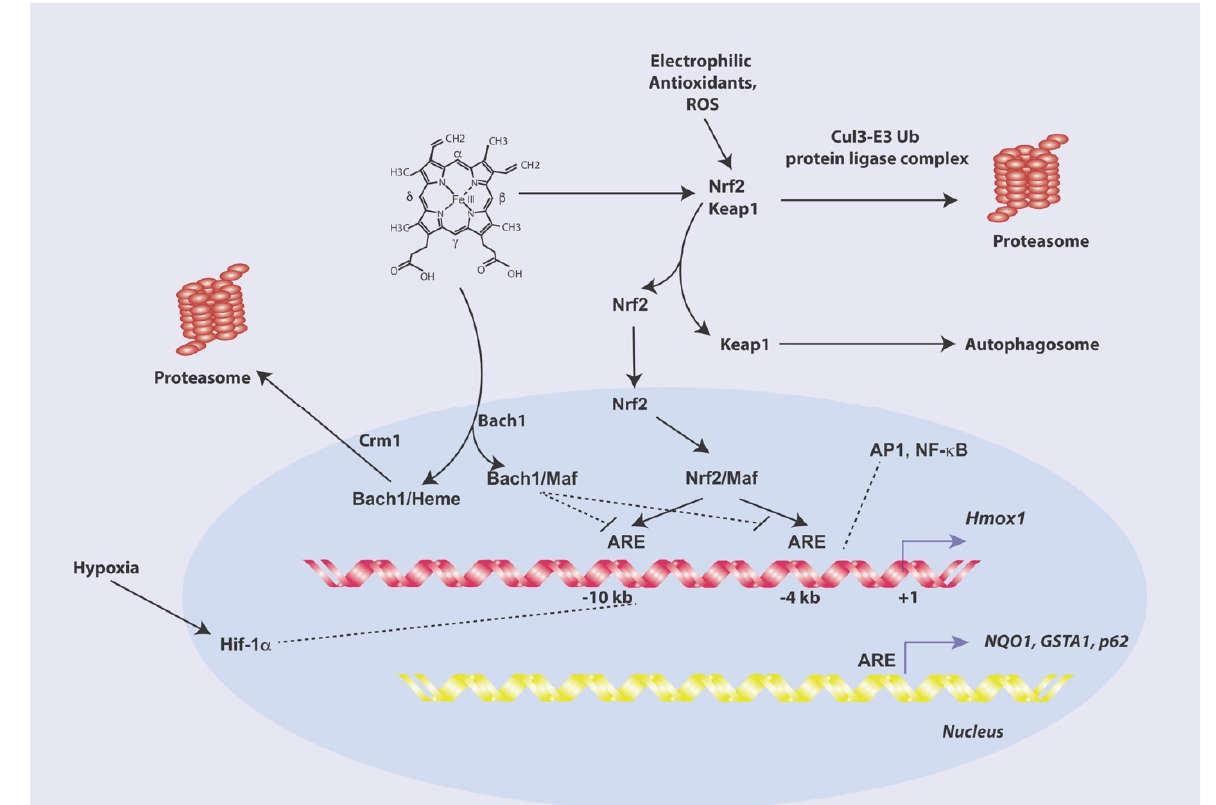
Figure 2. Regulation of HO-1 gene expression. The Hmox1 gene contains distal enhancer regions located at − 4 kb and − 10 kb and additional cis -elements in the proximal promoter region. HO-1 responds to transcriptional regulation by heme, electrophilic compounds, ROS, heavy metals and other diverse stimuli. HO-1 gene expression in response to diverse agents is regulated by the nuclear factor erythroid 2–related factor 2 (Nrf2). Nrf2 forms stable heterodimers with small Maf proteins, which target antioxidant response elements (ARE) within the enhancers. The Kelch-like ECH-associated protein (Keap1), serves as a cytoplasmic anchor for Nrf2 under basal conditions, and facilitates its proteasomal degradation. When cells are exposed to inducing stimuli, Keap1 disengages from Nrf2, enabling Nrf2 to translocate to the nucleus where it can transactivate Hmox1 gene expression. Nrf2 can also regulate other targets such as NAD(P)H: Quinone oxidoreductase 1 ( NQO1 ) and glutathione S-transferase ( GSTA1 ), and the autophagy substrate protein p62 SQSTM1 . The BTB and CNC homology-1 (Bach-1) protein acts as a transcriptional repressor of HO-1 and other Nrf2 target genes. Bach1 heterodimerizes with small Maf proteins to compete with Nrf2 for binding to ARE sequences in target gene promoters. Heme binding to Bach-1 inhibits DNA binding activity and promotes its nuclear export via the Crm1 transporter, leading to its proteasomal degradation. Additional transcription factors implicated in HO-1 transcriptional regulation include activator protein (AP)-1, hypoxia-inducible factor-1 (HIF-1), and nuclear factor-kappa-B (NF- κ B).